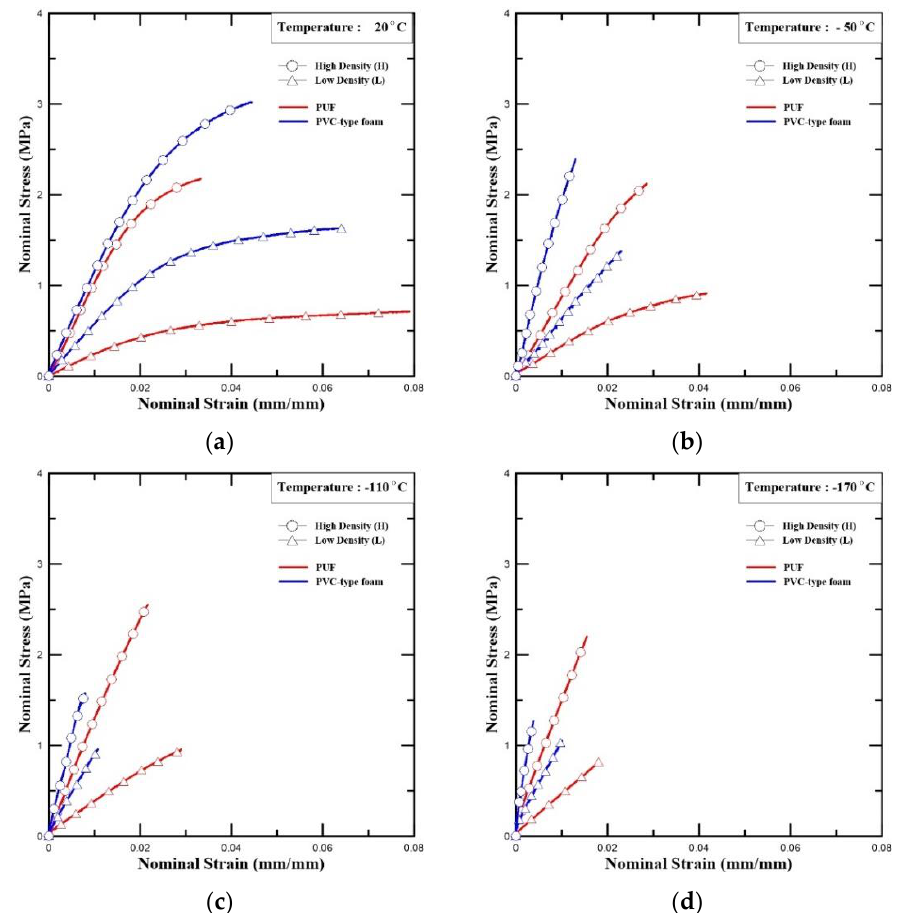
Figure 8. Stress – strain curve of the PUF (H, L) and PVC-type foam (H, L) with different tempera- tures: ( a ) 20 °C, ( b ) − 50 °C, ( c ) − 110 °C, and ( d ) −170 °C (tensile